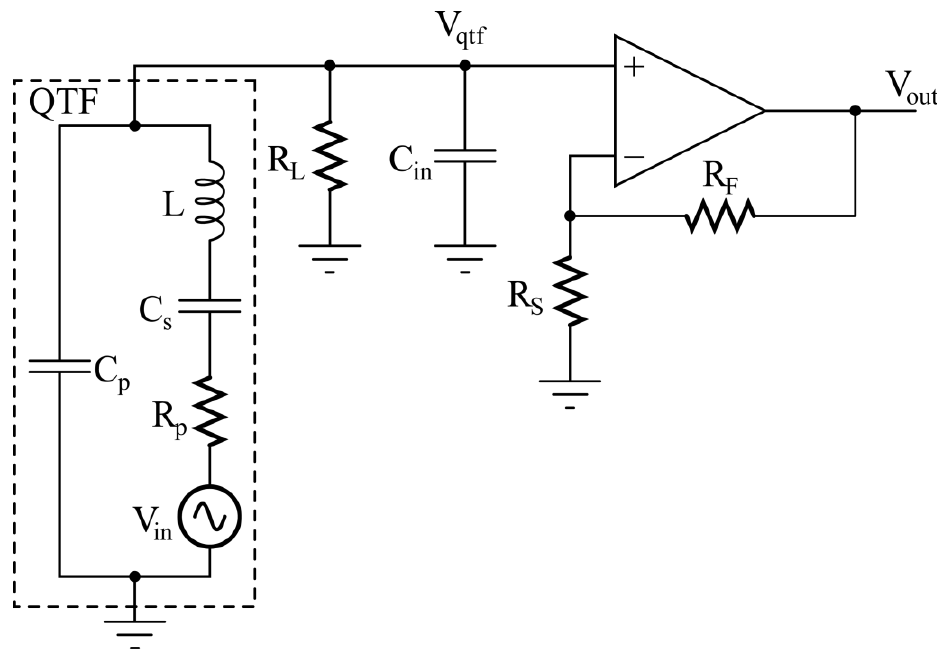
Figure 3. Butterworth – Van Dyke model for the QTF in the voltage-mode read-out circuit.